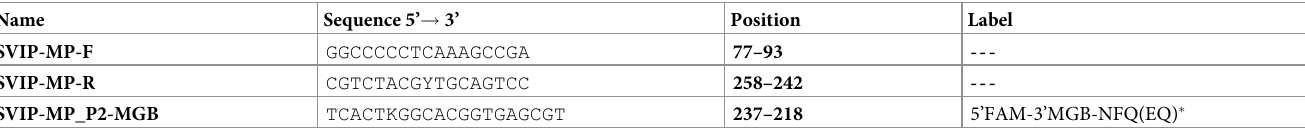
Table 1. The primer and probe